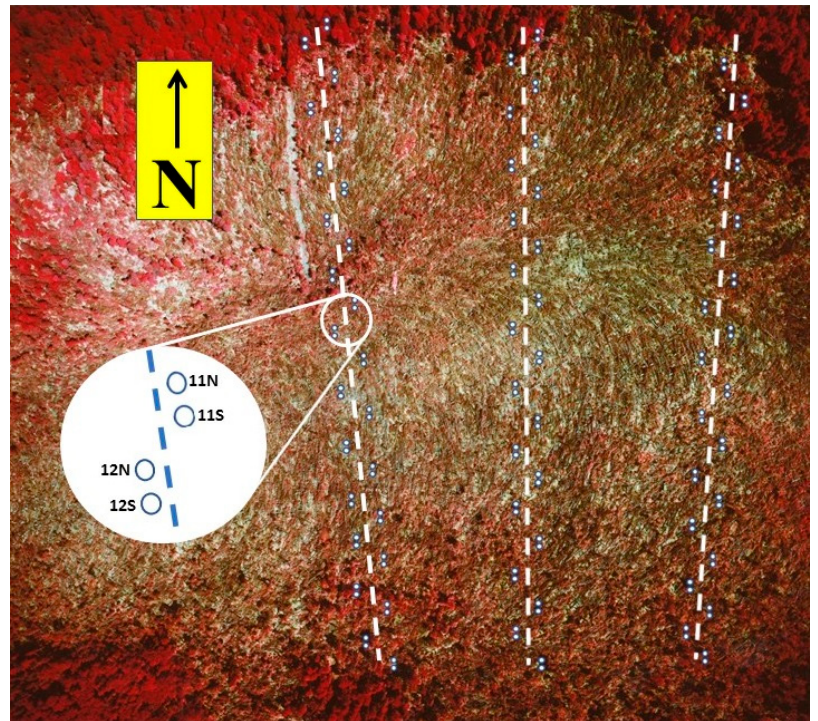
Figure 1. Aerial color infrared photo of the Tionesta Scenic Area study site, approximately two months after the tornado disturbance. Overlaid graphics show the distribution of the 0.5 m 2 sampling quadrats (not all shown, and not to scale) along the three north-south transects. North-south distance shown in the aerial photo is approximately 1 km. The white band in the upper (north) central area of the aerial photo is a gas pipeline right-of-way that had been cleared part of the way across the tornado swath by the time of the photo.